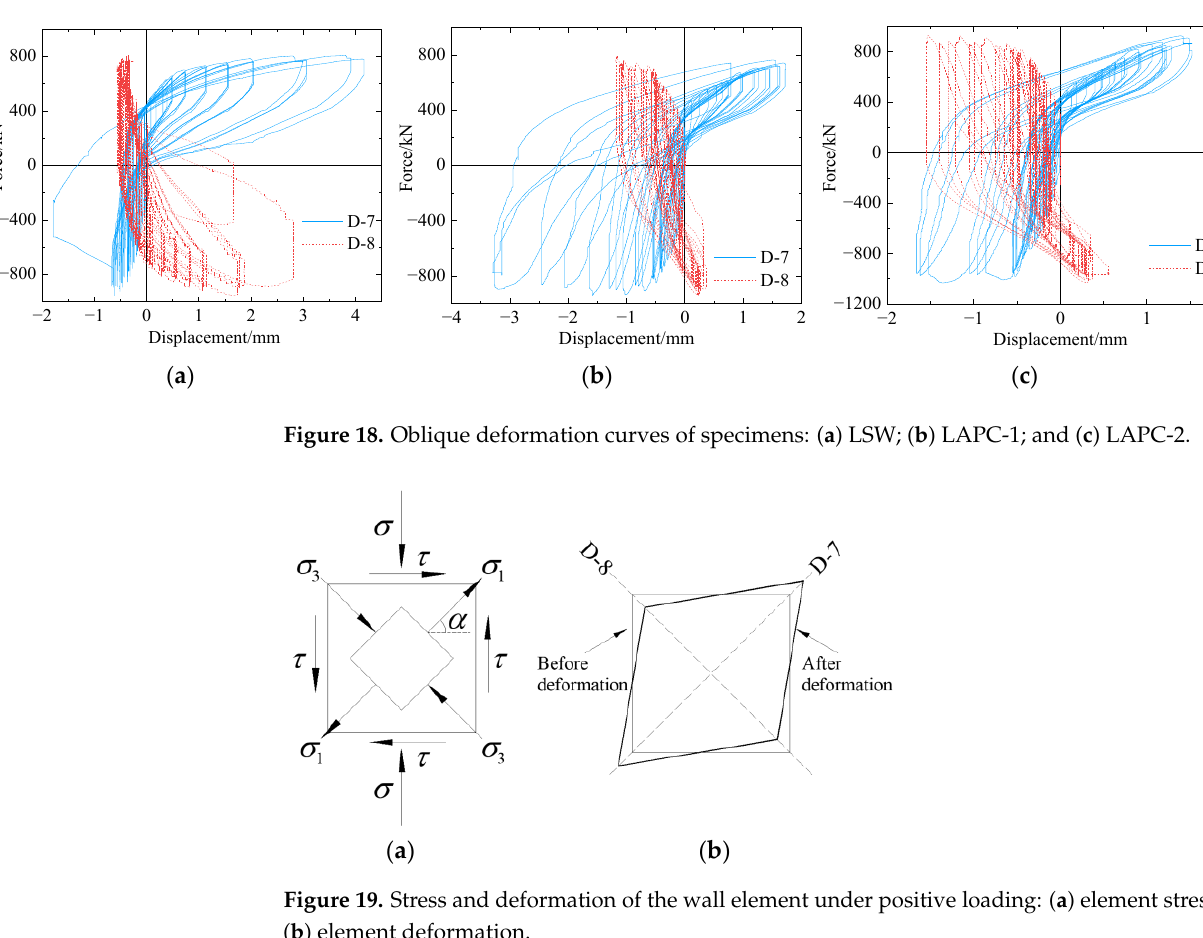
( c ) Figure 17. Force-out-of-plane displacement curves of specimens: ( a ) LSW; ( b ) LAPC-1; and ( c ) LAPC-2. It can be seen from Figure 17a that specimen LSW rotated counterclockwise outside the plane of the specimen under positive loading, and rotated clockwise under negative loading. When the load was small, the difference between the maximum out-of-plane dis- placements under positive and negative loading was not obvious, while when the load was large, the out-of-plane displacement under negative loading was significantly larger than that under positive loading, which was mainly due to the serious damage of the con- crete at the root of the straight-edge member in the later loading stage. As shown in Figure 17b,c, the out-of-plane displacement of the prefabricated specimens gradually rotated counterclockwise and accumulated during the loading process, mainly due to the exist- ence of grouting joints at the bottom of the prefabricated walls. Since the bottom of the prefabricated walls in this test was not chiseled, the accumulation of damage was prone to occur at the joint surface. When the specimen was positively loaded, the damage of the counterclockwise torsion and the accumulation of damage had appeared. Although the out-of-plane displacement of the counterclockwise torsion was reduced during the nega-